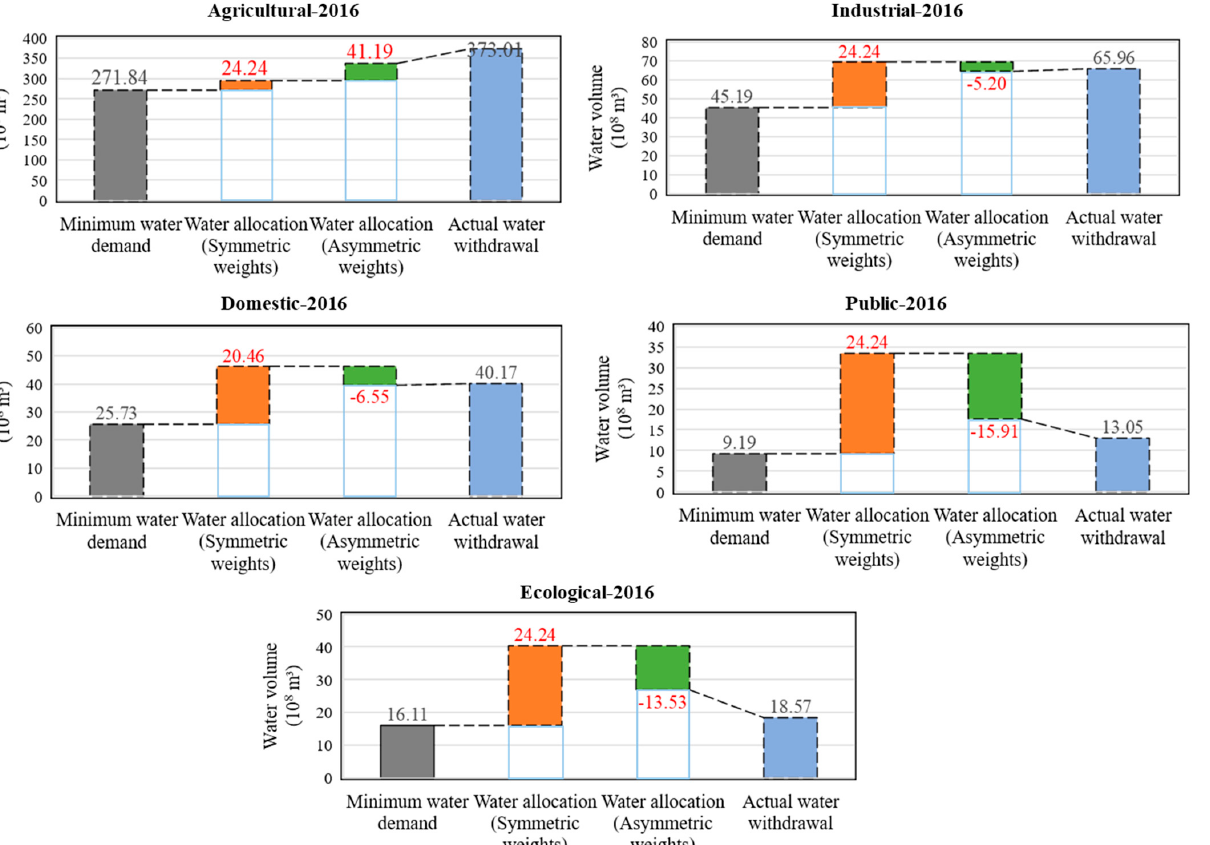
Figure 15. Water shortage between the allocated results and the actual allocation in 2016.